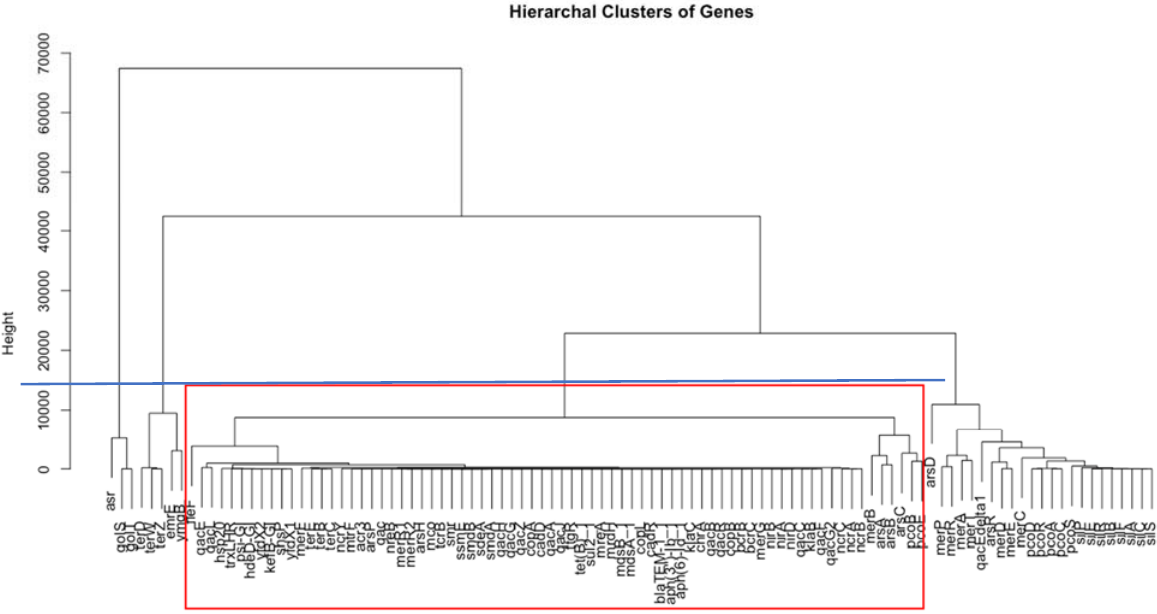
Figure 2. The hierarchical clustering result of stress response genes from the US historical data. Six clusters were obtained when the clustering tree was cut at the height indicated by the blue line. The genes not enclosed by the RED rectangle were regarded as the outlier genes that are highly detected in the pathogens with stress response.